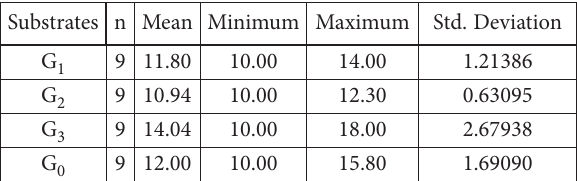
Table 6. Average plant heights by substrates